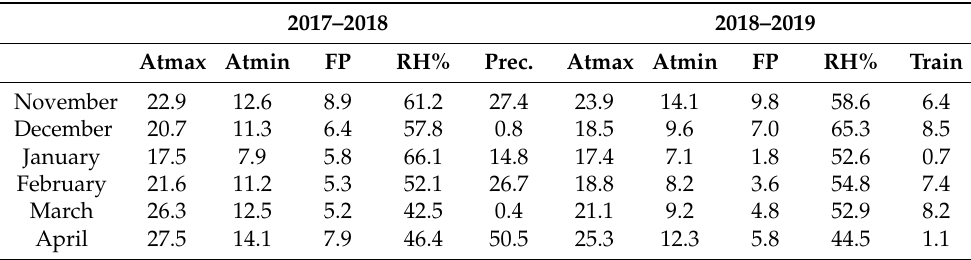
Table 1. Monthly average maximum temperature (ATmax, ◦ C), minimum temperature (ATmin, ◦ C), frost point (FP, ◦ C), average relative humidity (RH, %) and total rainfall (Train, mm) in the two growing seasons.